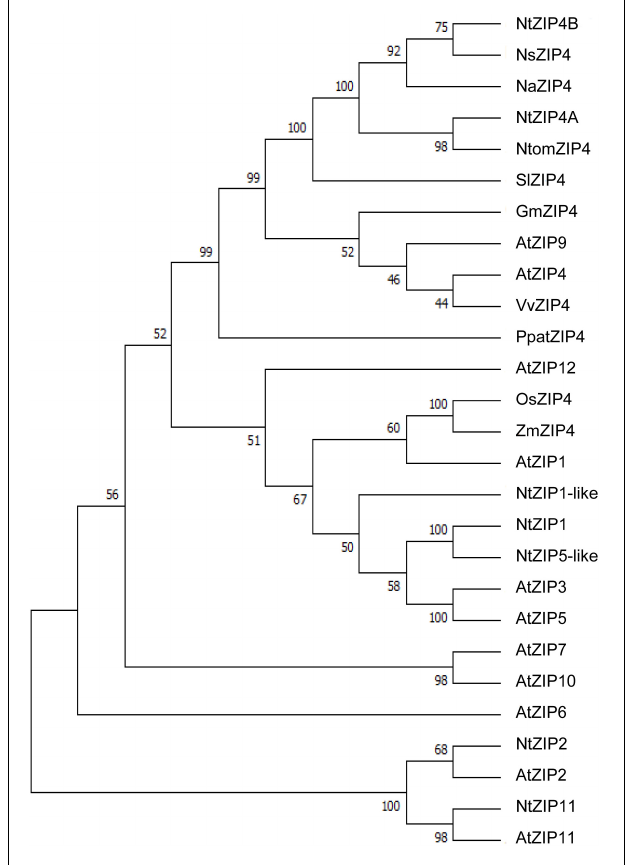
FIGURE 1 | Phylogenetic analysis of ZIP4 transporters from selected species. Unrooted phylogenetic tree for the ZIP proteins from eleven species: At, Arabidopsis thaliana ; Gm, Glycine max ; Na, Nicotiana attenuata ; Ns, Nicotiana sylvestris ; Nt, Nicotiana tabacum ; Ntom, Nicotiana tomentosiformis ; Os, Oryza sativa ; Ppat, Physcomitrella patens ; Sl, Solanum lycopersicum ; Vv, Vitis vinifera ; Zm, Zea mays . It was constructed based on amino acid sequences identified in NCBI database, using MEGA 7.0 software. The length of branches are proportional to the degree of divergence. Numbers in the figure represent bootstrap values (1000 replicates). The accession numbers are as follows: AtZIP1 – NP_187881.1, AtZIP2 – NP_200760.1, AtZIP3 – NP_180786.1, AtZIP4 – NP_001320672.1, AtZIP5 – NP_172022.1, AtZIP6 – NP_180569.1, AtZIP7 – NP_178488.1, AtZIP9 – NP_001329099.1, AtZIP10 – NP_174411.2, AtZIP11 – NP_564703.1, AtZIP12 – NP_201022.1, GmZIP4 – XP_014624832.1, NaZIP4 – XP_019247882.1, NsZIP4 –